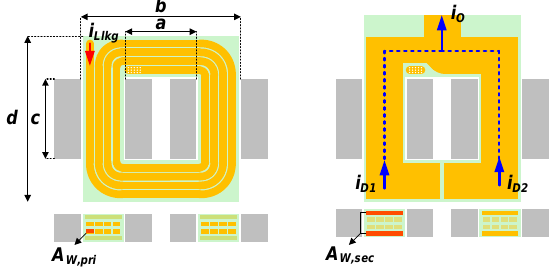
Figure 9. Winding parameters of the integrated planar transformer.